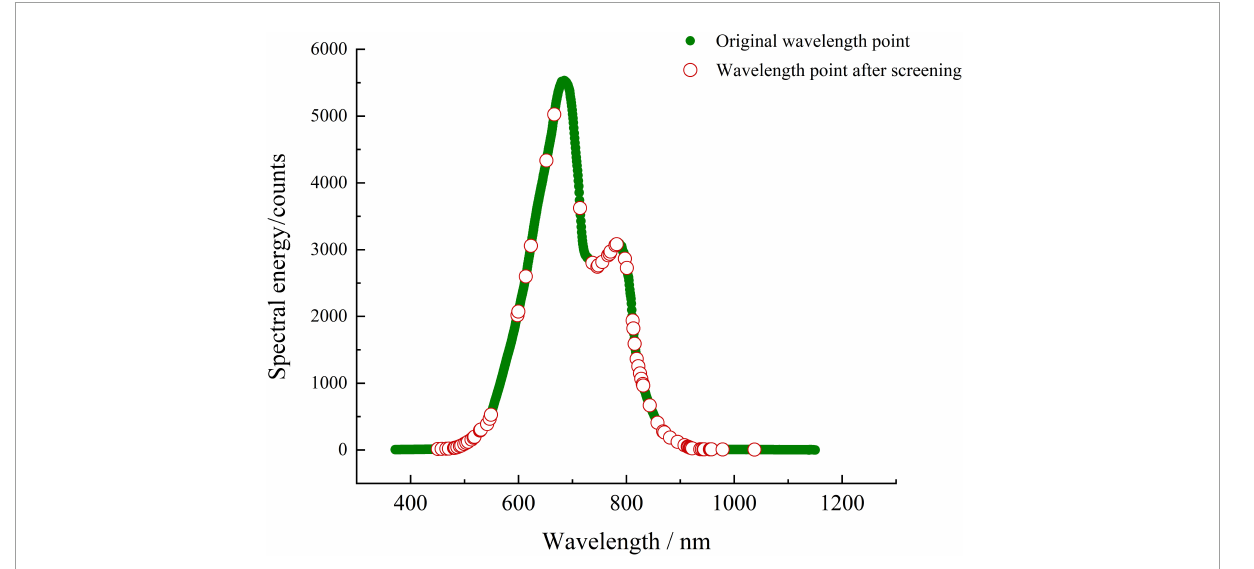
FIGURE8 Distribution of feature spectral variables for Yali pears selected by CARS method.